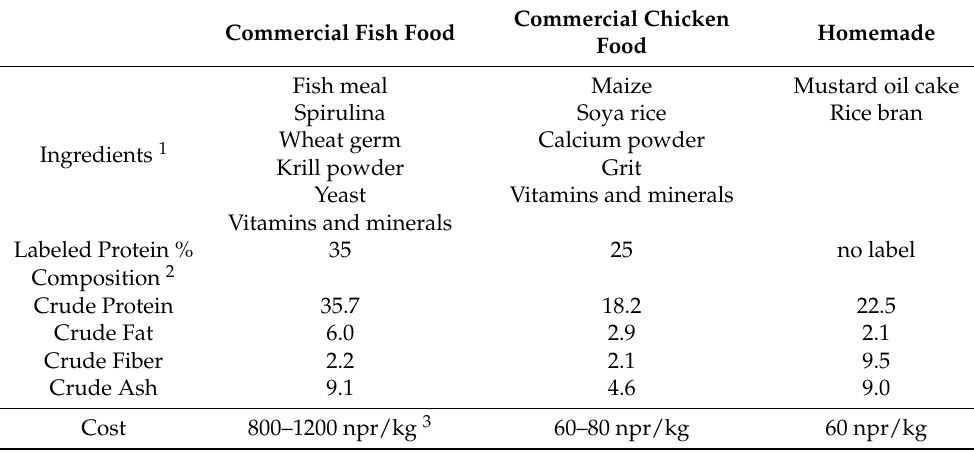
Table 1. Primary ingredients, proximate composition, and costs of three types of fish food used in experimental aquaponics